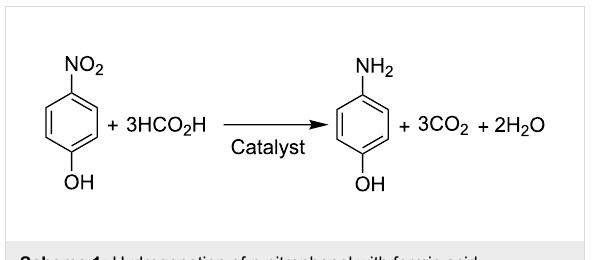
Scheme 1: Hydrogenation of p -nitrophenol with formic